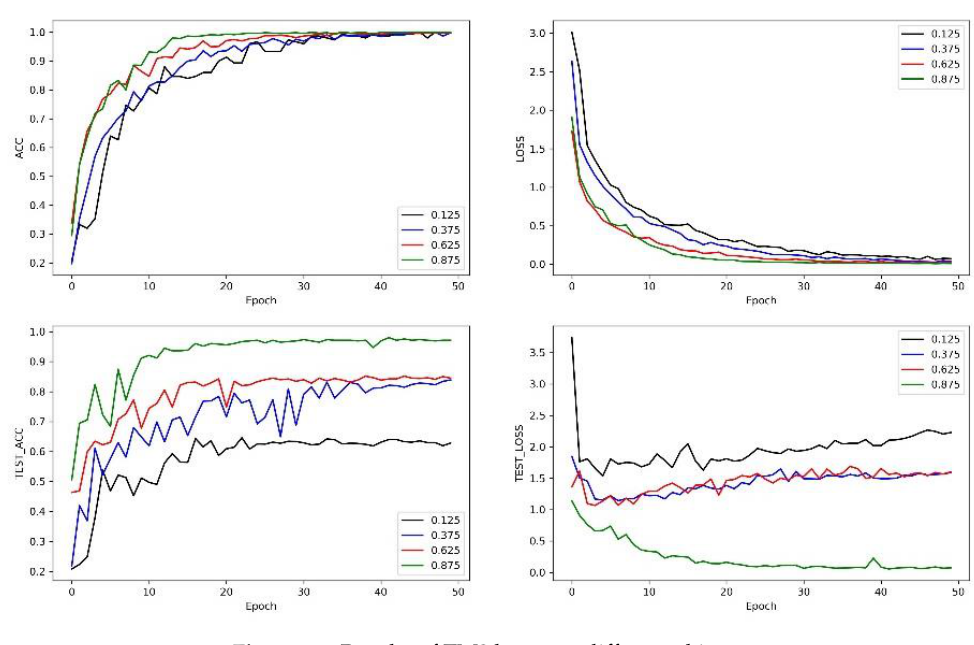
Figure 16. Results of TM2 between different objects.